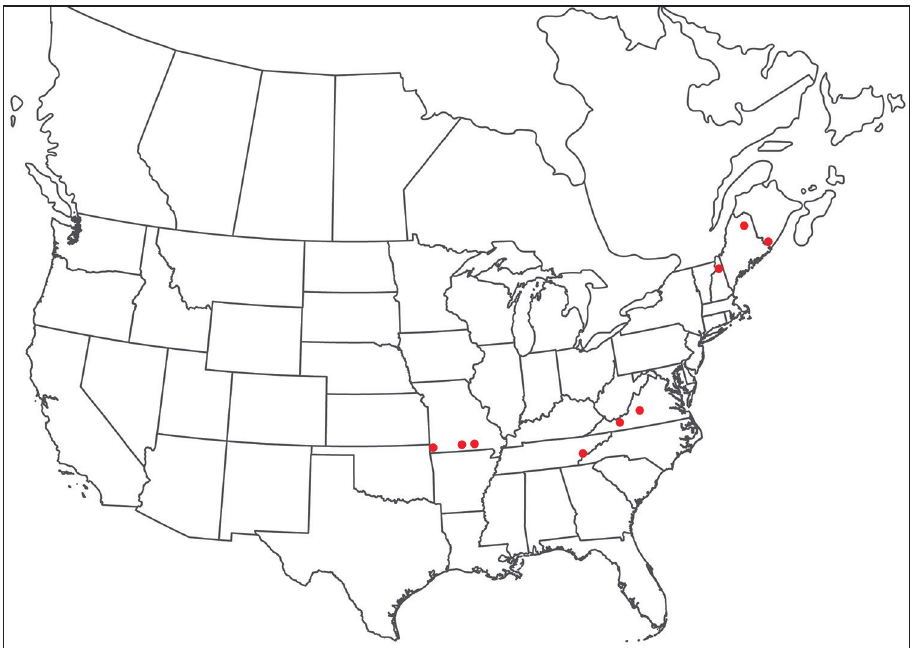
Figure 137. Torrenticola malarkeyorum sp. n.